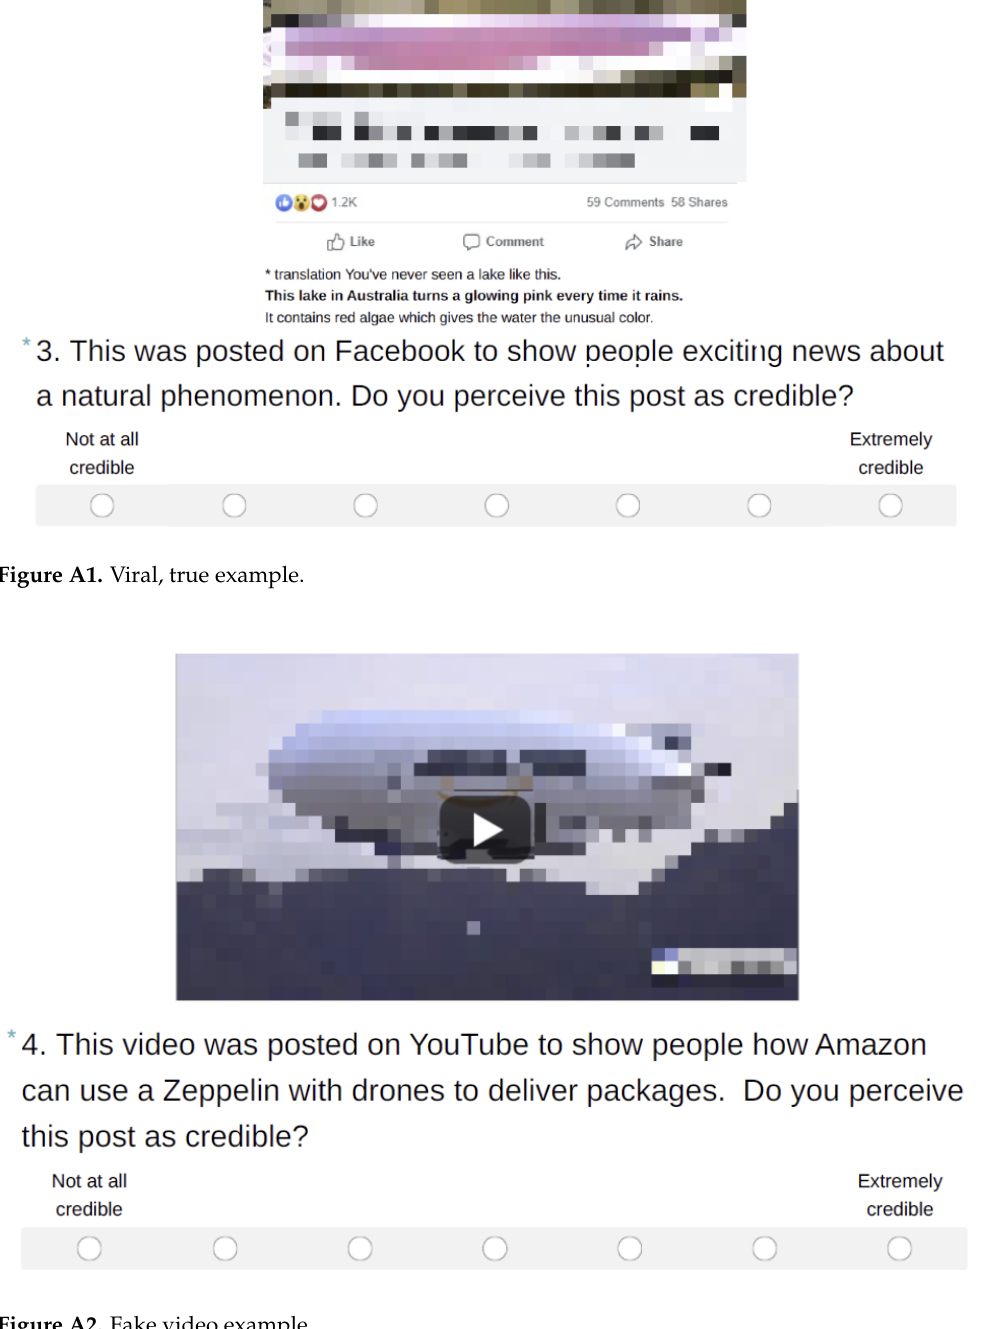
Figure A2. Fake video